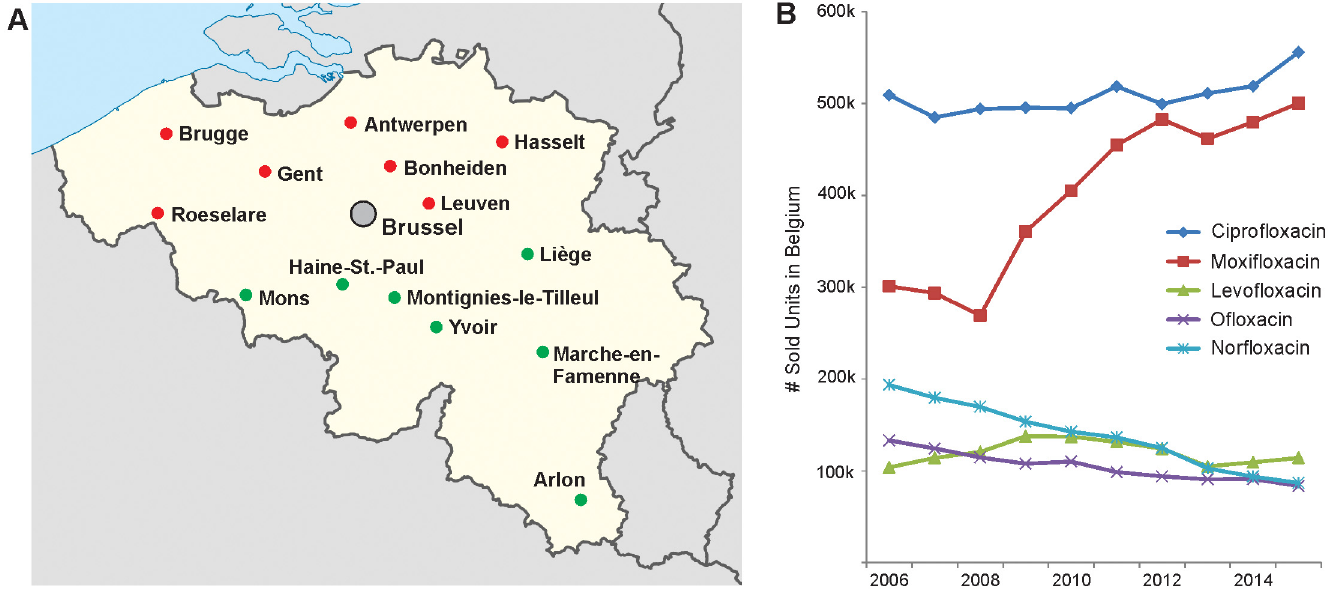
Fig 1. Surveillance of Fluoroquinolone resistance in Belgian non-invasive S . pneumoniae isolates. A. Clinical laboratories participating in the survey. Participating Flemish and Walloon laboratories are indicated in red and green, respectively. B. Evolution of the total Belgian fluoroquinolone use over the last decade, expressed as yearly sold units of the five main fluoroquinolones (source: IMS dataview, data December 2015).